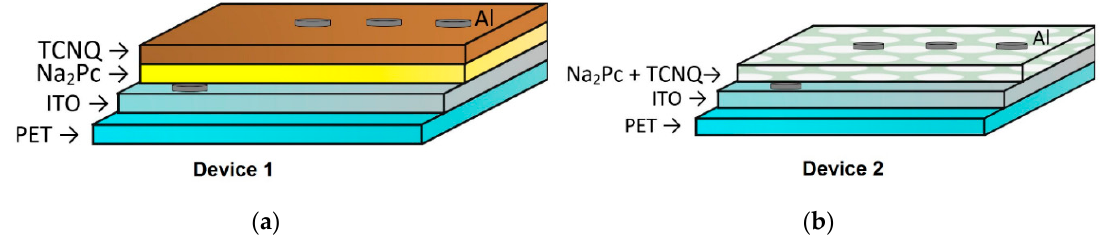
Figure 1. Structure of the ( a ) flat heterojunction and ( b ) dispersed heterojunction